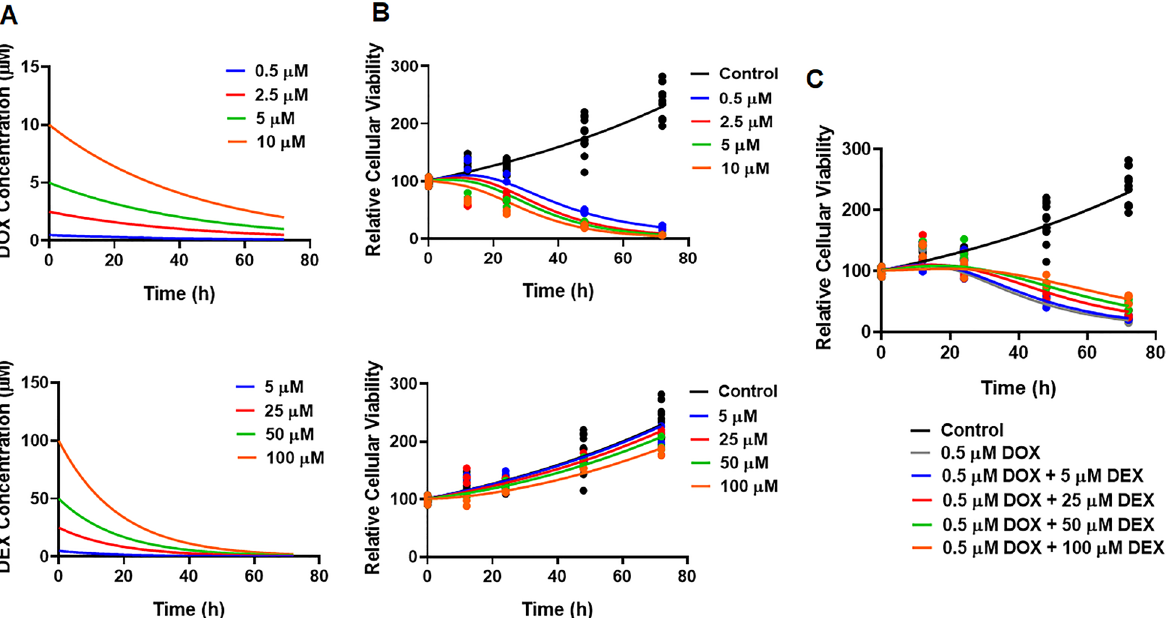
Figure 2. ( A ) Simulated degradation kinetics of DOX ( top ) and DEX ( bottom ) at indicated concentrations in a cell culture media. The first-order degradation rate (k deg ) for DOX and DEX were estimated as in Supp. Fig. 1 and were assumed to be constant at indicated concentrations. ( B , C ). Model fittings for the in vitro effects of the single agents, DOX ( B , top) and DEX ( B , bottom ) as well as the combinatorial effects of DOX and DEX ( C ) at indicated concentrations over time on the cell viability of human cardiomyocytes AC16s (toxicodynamic model). All observed data are represented by solid circles while the smooth lines are model fittings or